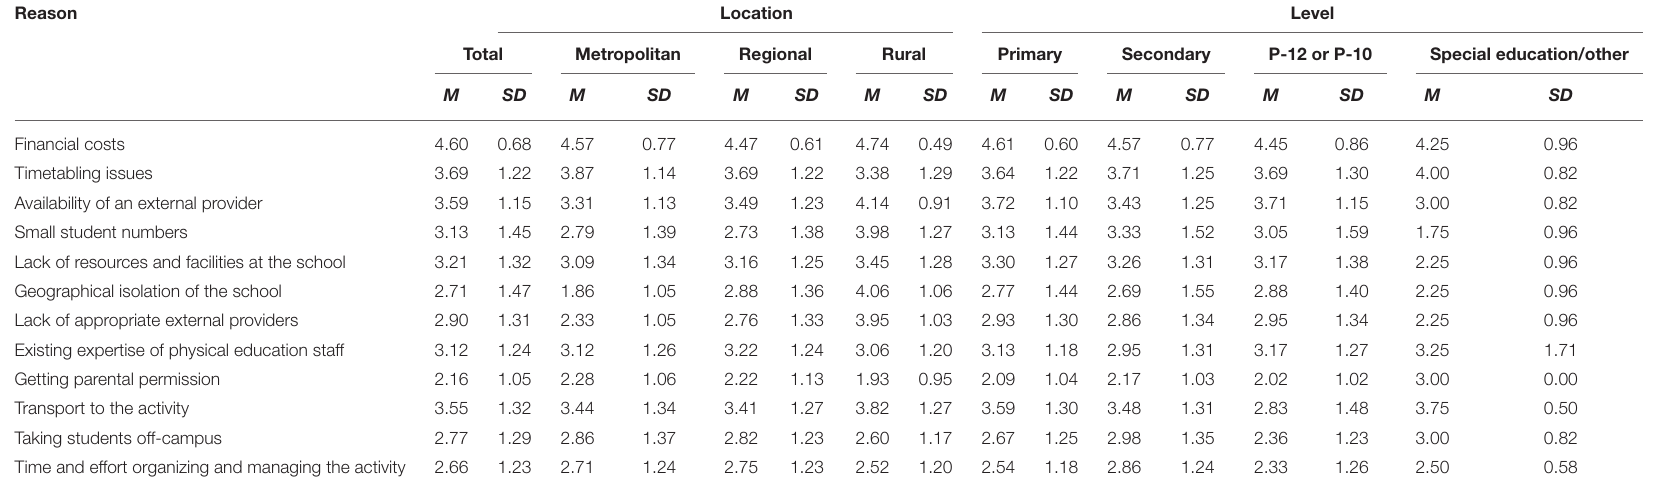
TABLE 5A | Barriers to outsourcing physical education content to external providers by type of school.